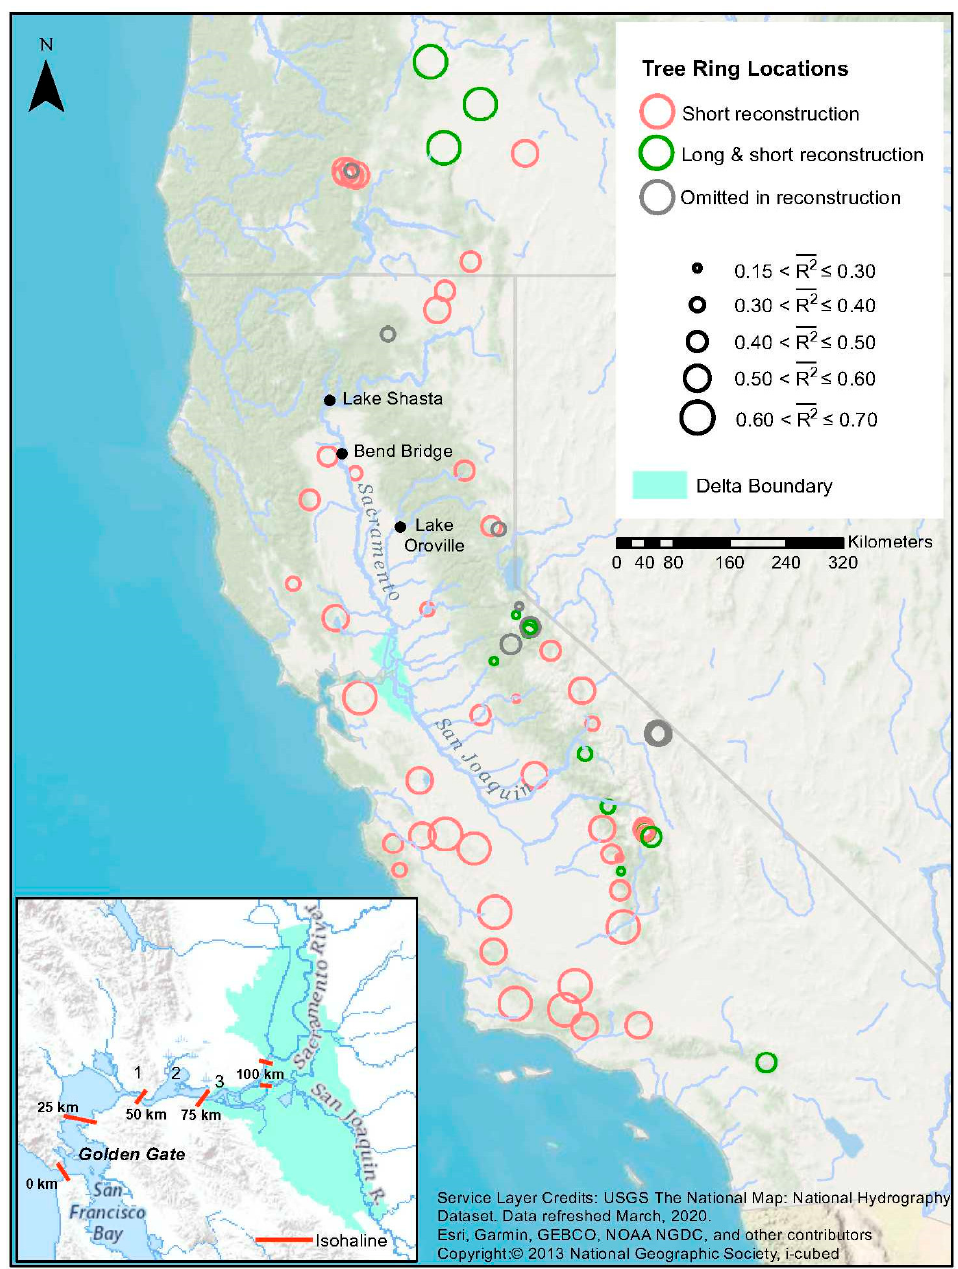
Figure 1. Study location map showing the locations of tree ring sites used in the analysis. Circles mark sites contributing to the short (60 sites) and long (13 sites) reconstructions. Circles sized proportional to percentage of variance explained in regression models for single site reconstructions (SSRs). Sites contributing to long reconstruction marked with green; those as well sites marked with red contribute to the short reconstructions. Nine sites (gray) were screened out and not used in later reconstruction steps.